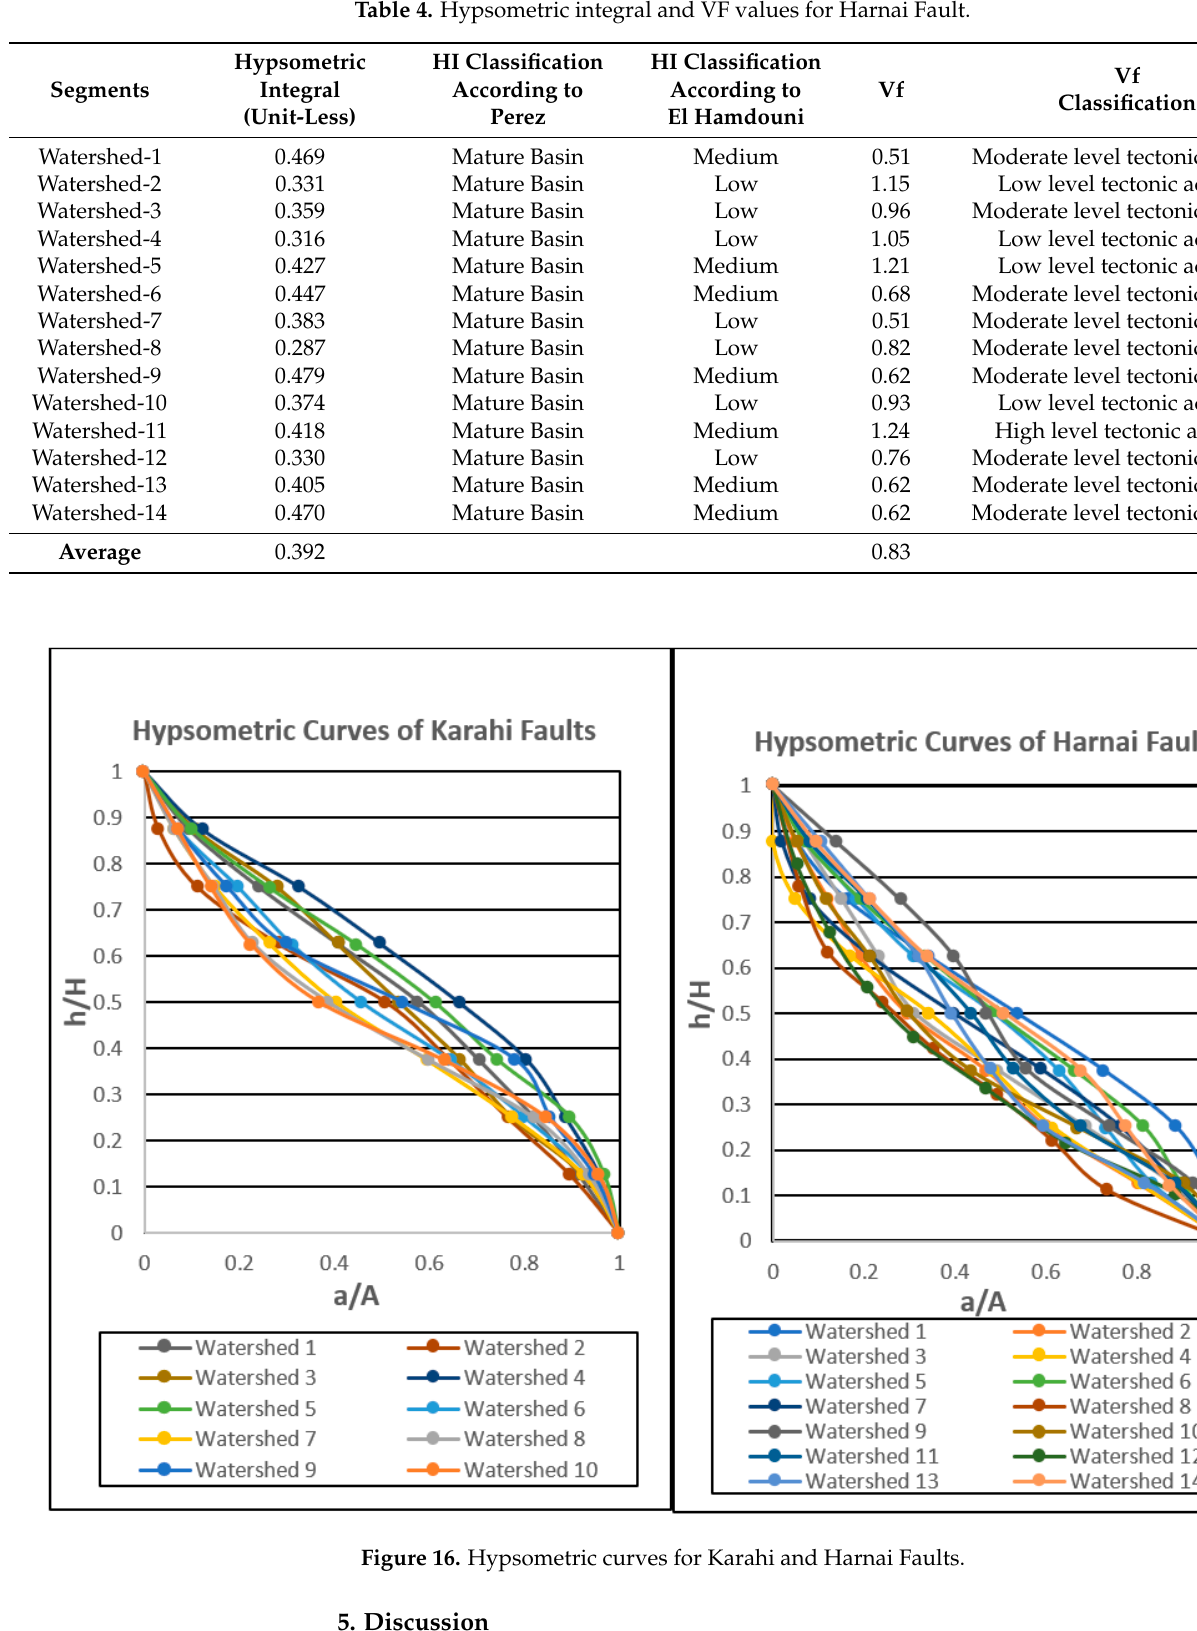
Table 4. Hypsometric integral and VF values for Harnai Fault.